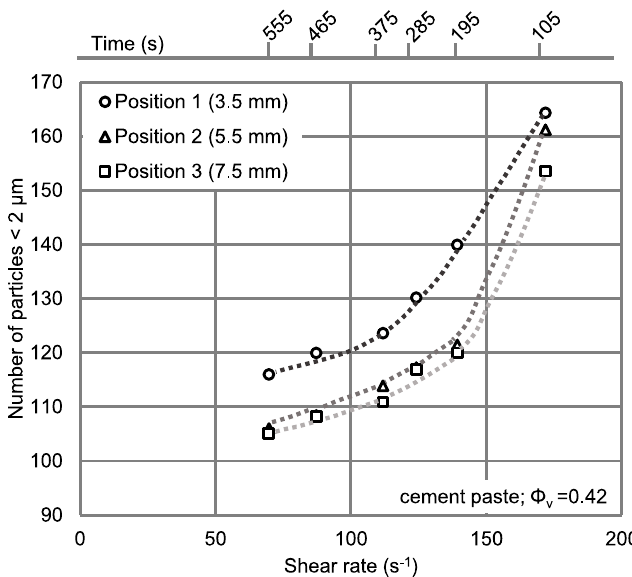
< 2 µ m as a function of the average shear rate on the vane probe at di ff erent Figure 9. Particle numbers < 2 μ m as a function of the average shear rate on the vane probe at different Figure 9. Particle numbers radial positions of the FBRM probe; time shows the beginning of the coupled FBRM-rheometer